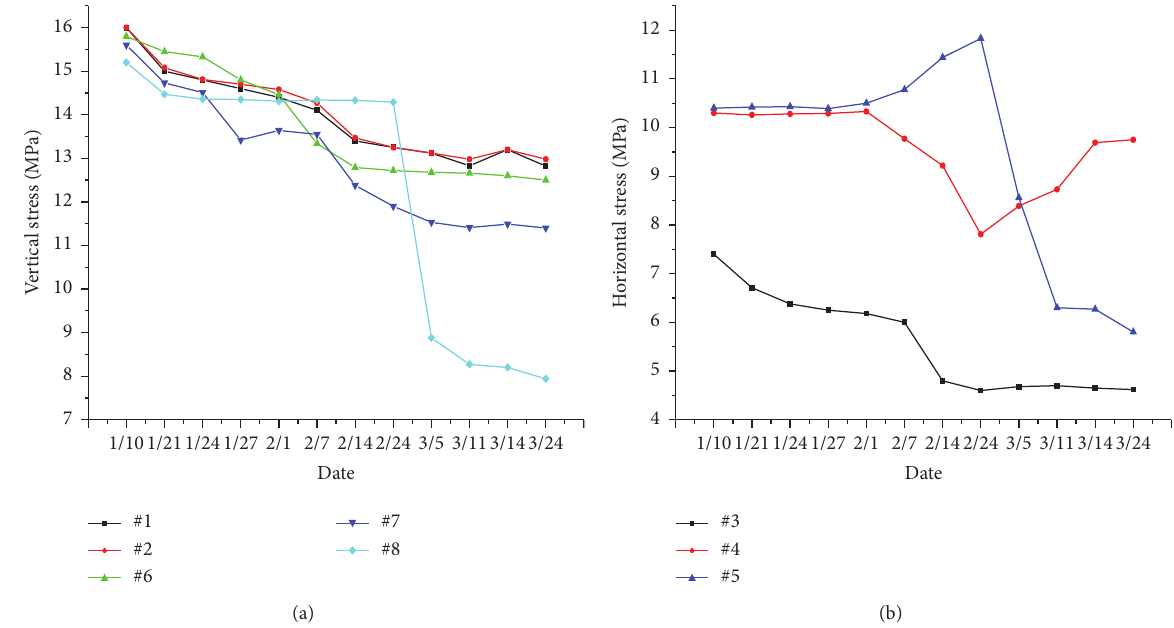
Figure 11: Stress curves of eight monitoring gauges: (a) vertical stress change curve and (b) horizontal stress change It is the surrounding rock rather than the permanent sup-